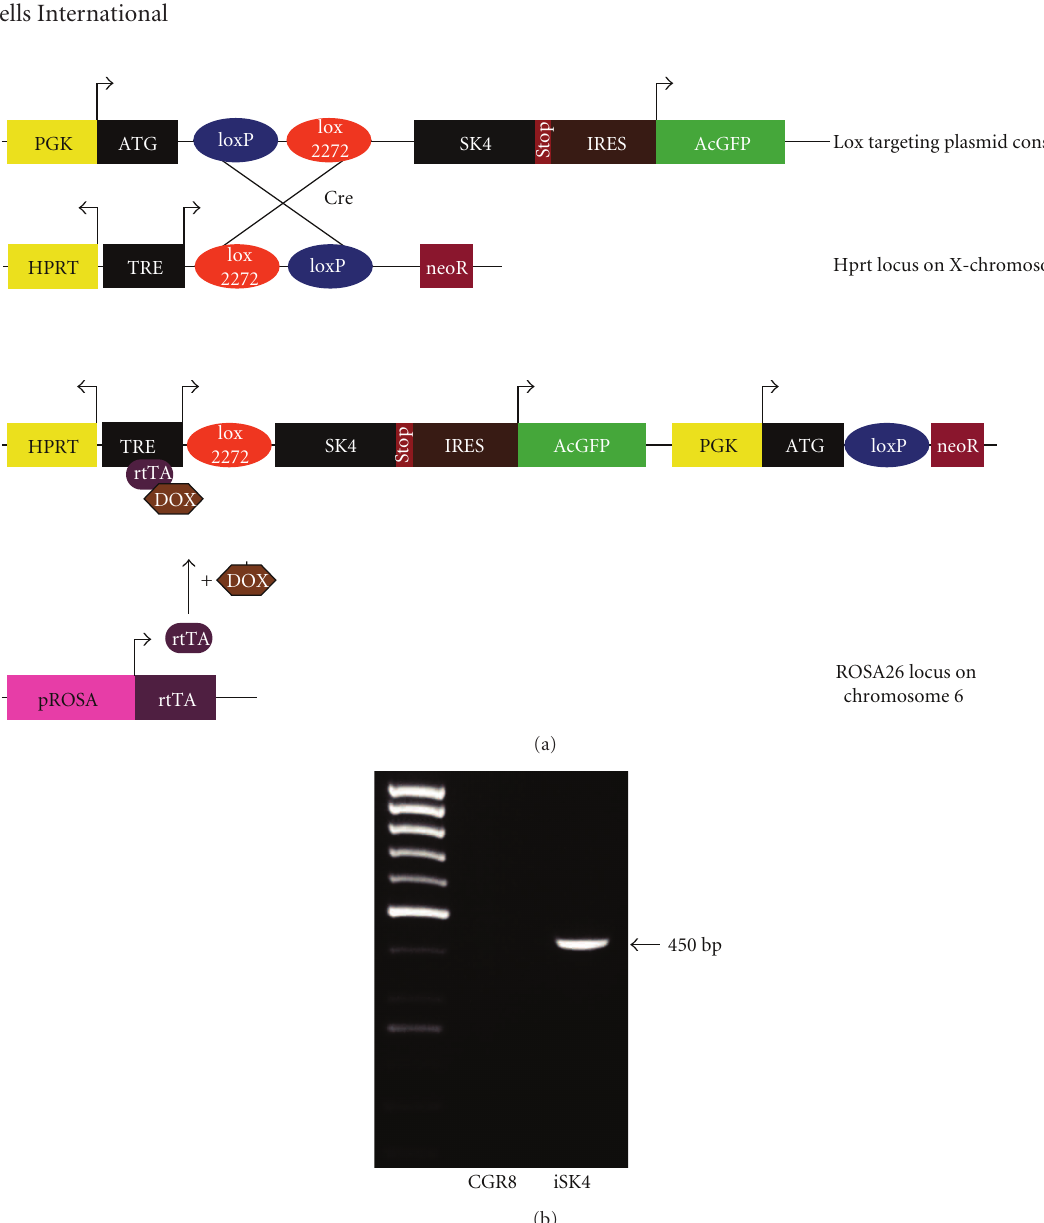
the desired SK4 expressing plasmid. The SK4 construct